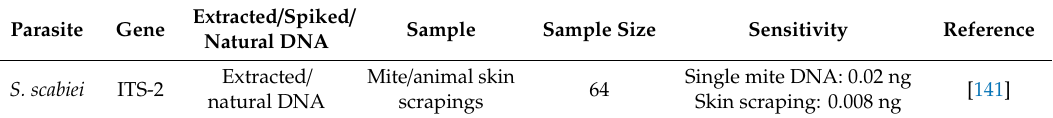
Table 14. Publications found in the US National Library of Medicine National Institutes of Health (NCBI-PubMed) reporting the standardisation of the LAMP technique as a useful tool for diagnosing scabies in the definitive